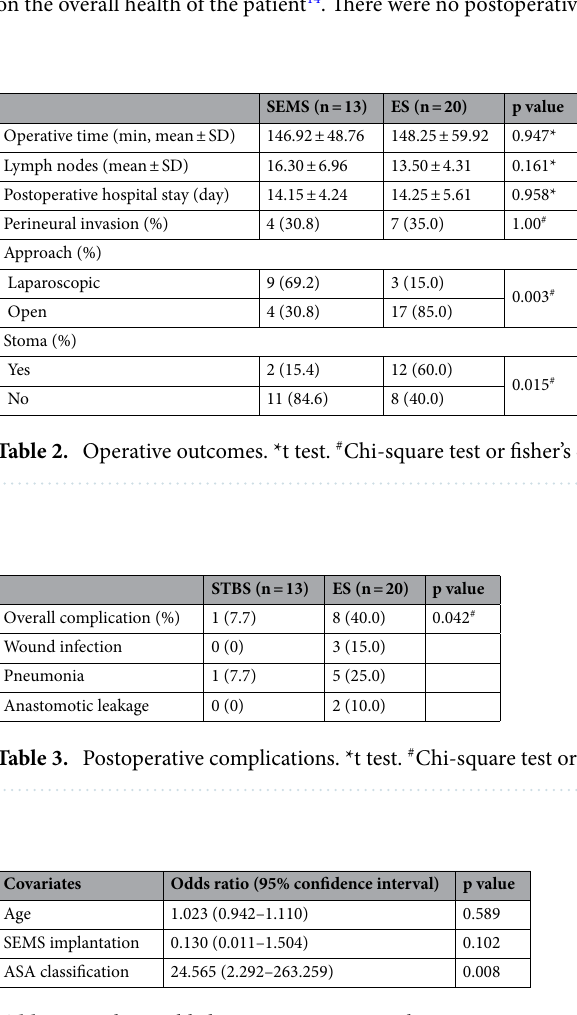
Table 4. Multivariable logistic regression